Question: Give a one-sentence summary of this figure.
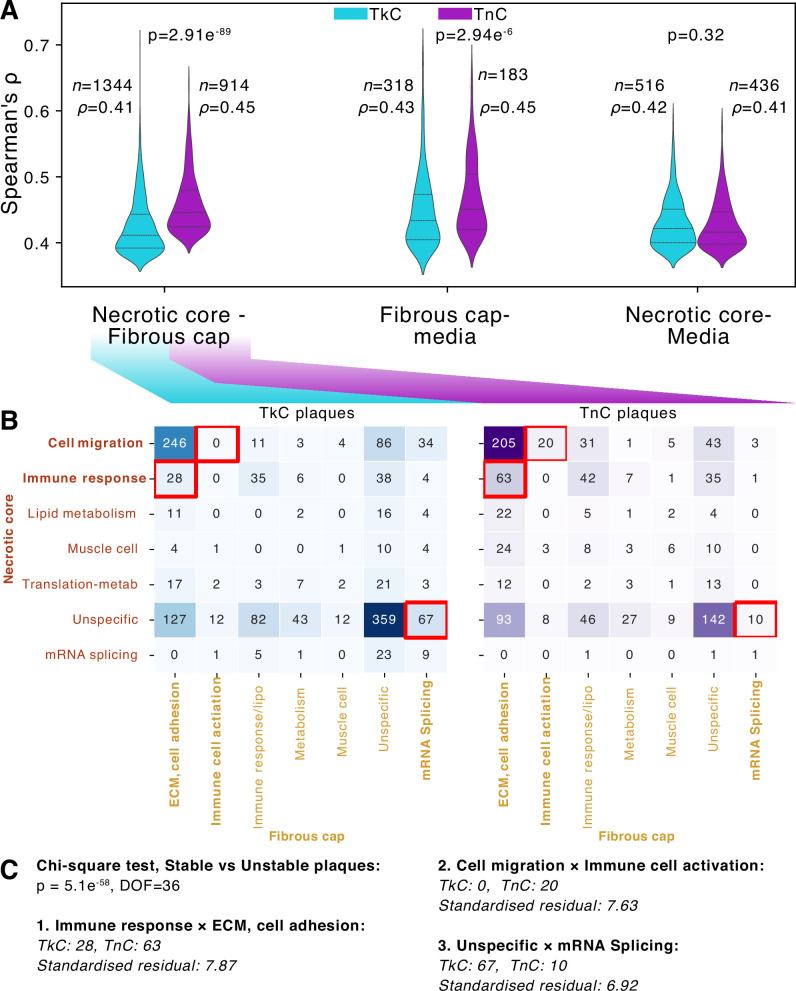
Answer: PCSK9-associated responses to oxidative/inflammatory stress in primary VSMCs. a , Experimental design for modeling oxidative/inflammatory stress responses in primary human VSMCs. VSMCs isolated from CEA specimens were cultured under control conditions (ethanol vehicle) or stimulated with POVPC, with parallel PCSK9 knockdown (siPCSK9) or negative-control siRNA (siSCR). Cellular proteomes and secretomes were profiled by data-independent acquisition (DIA) proteomics and integrated for downstream analyses. b , PCSK9 abundance in the secretome across experimental conditions ( n = 3 per condition, P < 0.05). Points indicate biological replicates, boxes indicate the median and interquartile range, and whiskers show the data range. Filled circles indicate observed values, and open circles indicate imputed values; P values ( t -test) for the indicated pairwise comparisons are shown. c , Knowledge graph summary of POVPC-associated and PCSK9-associated molecular changes. Nodes represent genes/proteins (circles), biological processes (gray squares) and cell-identity terms (orange squares); edges indicate curated term–gene links and coexpression relationships (green dashed lines). For each gene/protein node, the upper half shows the log 2 fold change for the PCSK9 knockdown effect under POVPC stimulation (siPCSK9 + POVPC versus siSCR + POVPC), and the lower half shows the log 2 fold change for POVPC versus control (ethanol). Color indicates direction and magnitude of change (blue, increased; red, decreased; scale shown). d , Pathway activity changes relative to control (ethanol; gray, n = 6) after POVPC stimulation (red, n = 9) and after PCSK9 knockdown with POVPC stimulation (blue, n = 9). Shaded regions indicate pathways with significant overall differences ( P ≤ 0.025, one-way ANOVA), boxes indicate the median and interquartile range, and whiskers show the data range. Source data